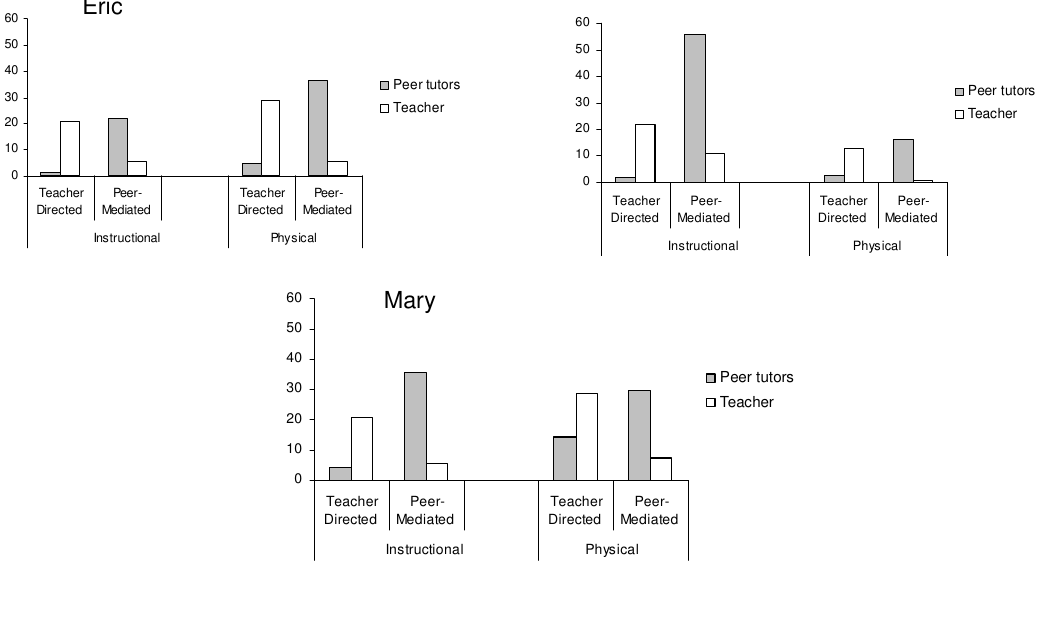
Mean percentage of intervals during which teachers and peer tutors were involved in instructional and physical interactions with students with